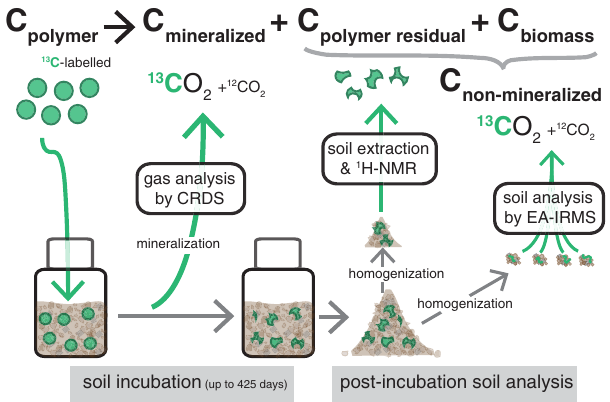
Fig. 7 | Analytical work fl ow to study biodegradation of 13 C-labelled poly- (butylenesuccinate)(PBS)insoils. Followingadditionof 13 C-labelledPBStosoils, mineralization of PBS-added 13 C to 13 CO 2 was continuously followed by analysis of the ef fl uent gas from incubation bottles using isotope-speci fi c cavity ring-down spectroscopy (CRDS). Following incubations, the total amount of non-mineralized PBS-added 13 C that remained in the soil, C non-mineralized , was determined in chloroform-sonication treated soils by elemental analysis coupled to isotope ratio mass spectrometry (EA-IRMS). Finally, the amount of residual PBS, C polymer residual , was quanti fi ed by extracting remaining PBS from soils in chloroform-methanol, followed by quanti fi cation of the extracted PBS in deuterated chloroform using quantitative proton nuclear magnetic resonance spectroscopy ( 1 H NMR). We note thatthedepictionofsphericalPBSparticleswithuniformsizeaddedtothesoilwas chosen for simplicity and does not re fl ect the actual size distribution and likely various shapes of actually added PBS